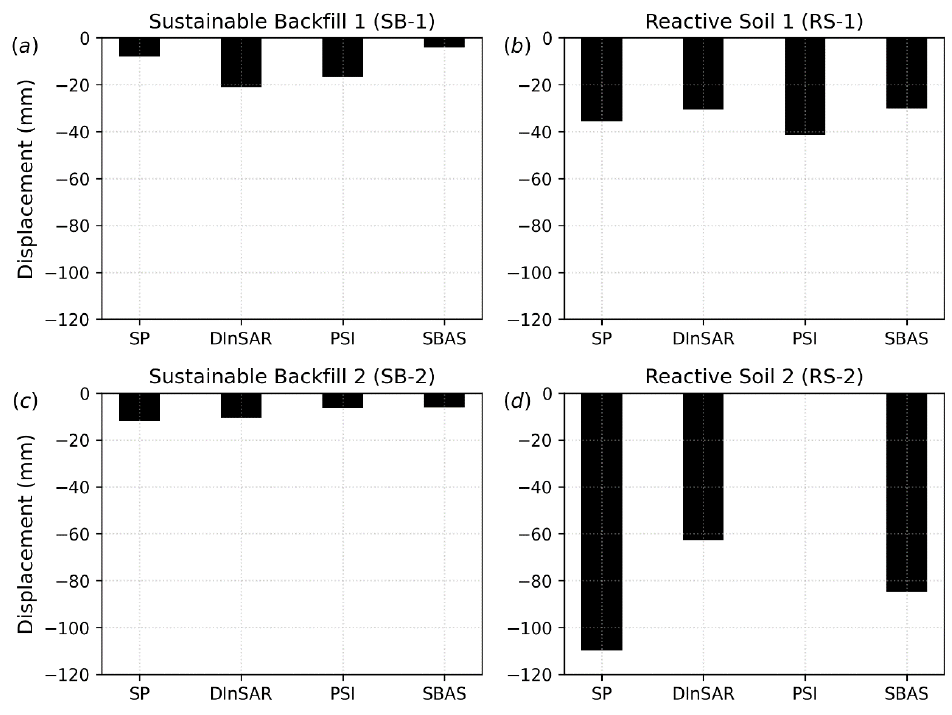
Figure 10. InSAR estimates of ( a ) SB-1, ( b ) RS-1, ( c ) SB-2, and ( d ) RS-2.